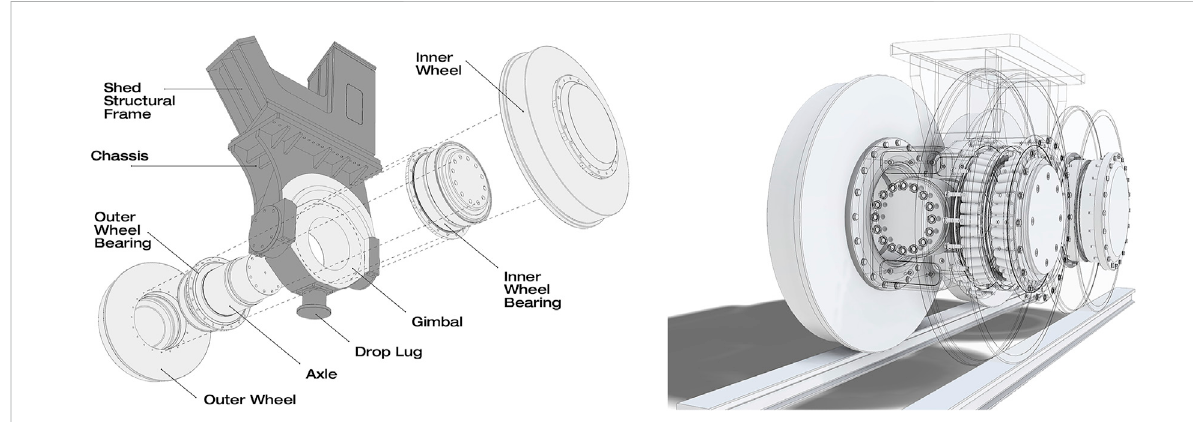
FIGURE 9 Details of the Boogie Wheels; reprinted with permission of The Shed/Diller Sco fi dio + Renfro.